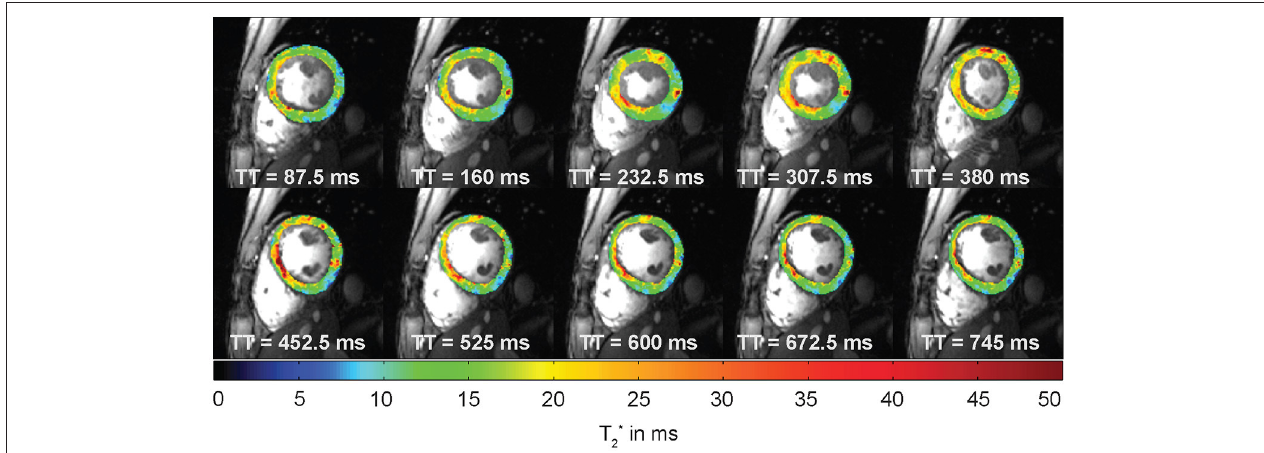
FIGURE 6 | Example of cardiac phase resolved myocardial T 2 * mapping of a short axis view of a healthy volunteer (10 out of 20 phases shown). Spatial resolution = (1.1 × 1.1 × 4.0) mm 3 . Temporal resolution = 37 ms. T 2 * variations can be observed across the cardiac cycle. TT indicates the time since the